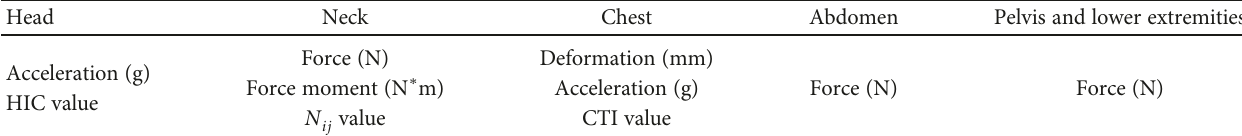
Table 2: Common injury indicators for di ff erent parts of the human